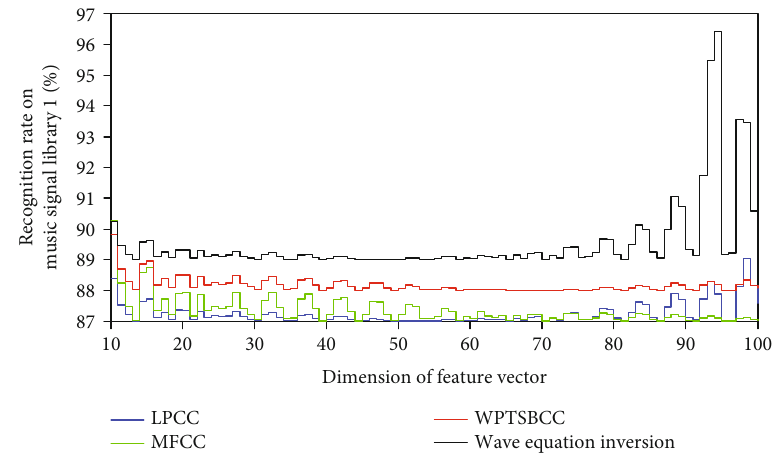
Figure 5: The recognition rate of di ff erent feature vector dimensions on the music signal library 1.